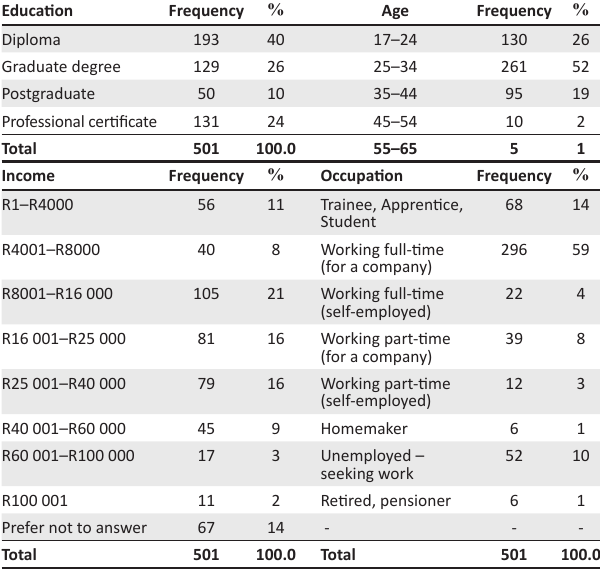
TABLE 1: Sample demographic